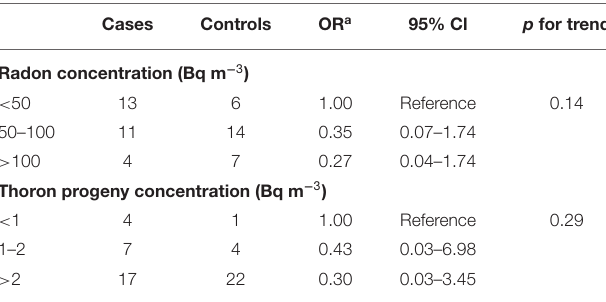
TABLE 2 | Distributions of subjects and odds ratios ( OR s) for lung cancer according to measured radon and thoron progeny concentration.